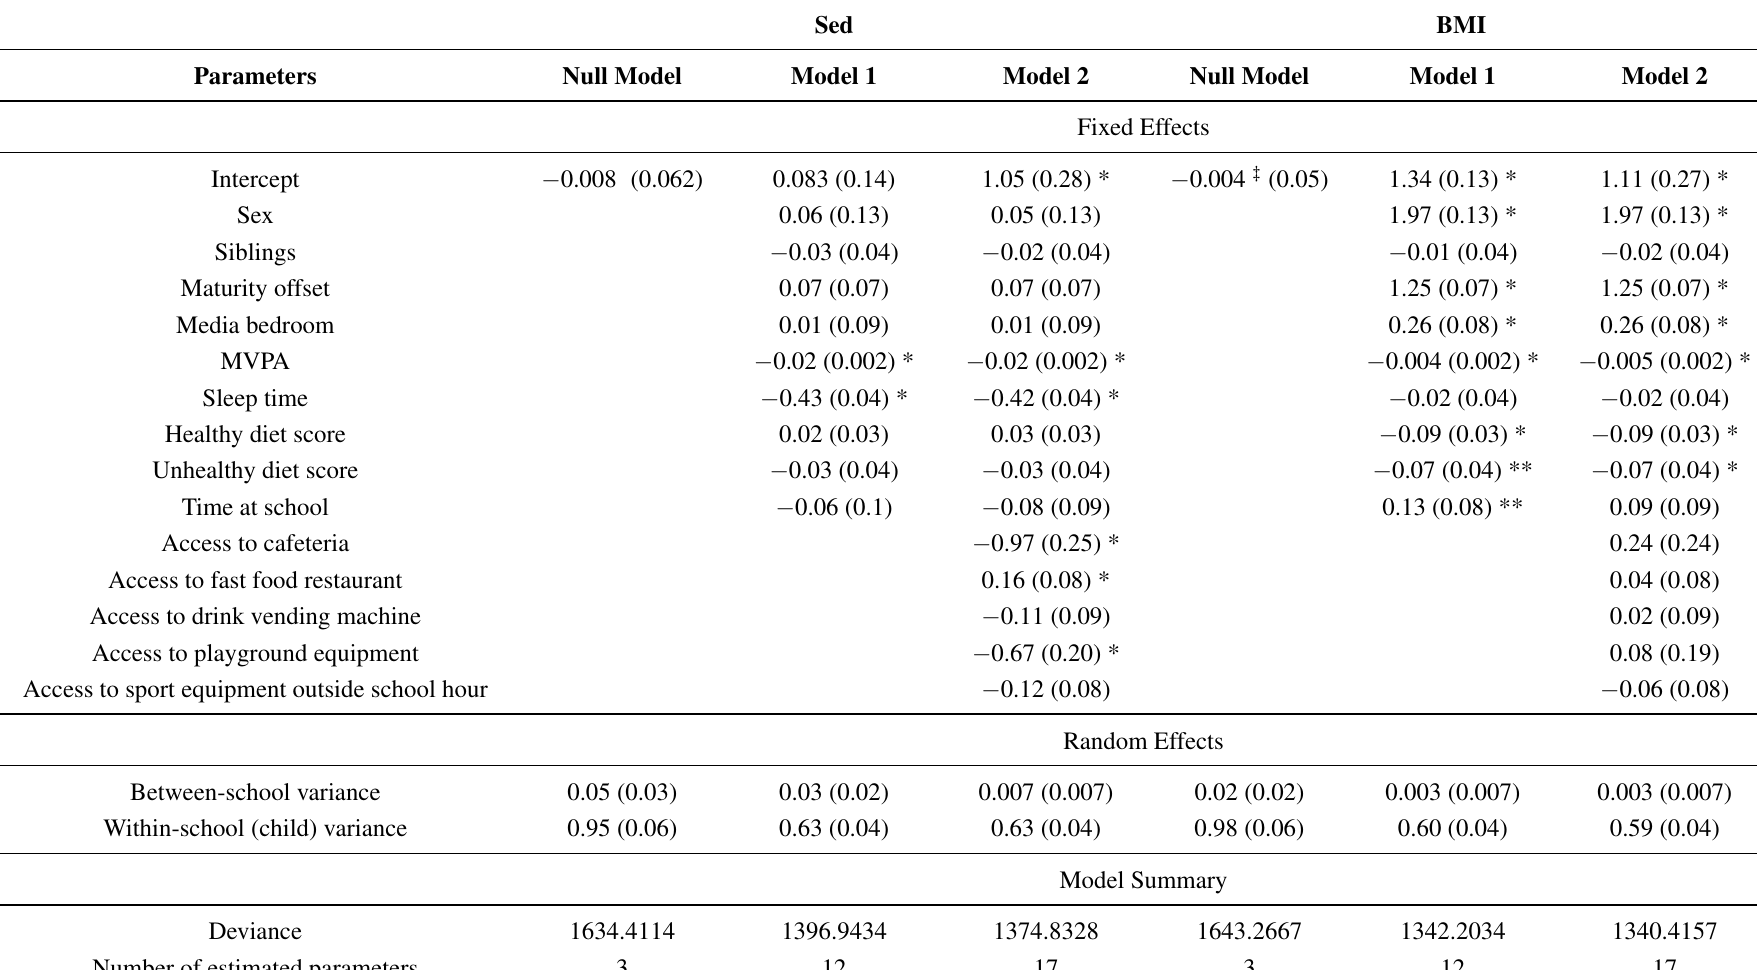
Table 3. Results summary of modelling Sed and BMI: estimates (standard